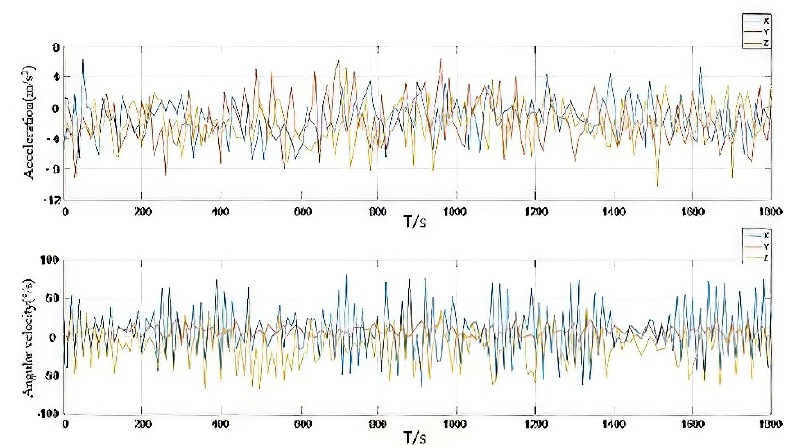
Figure 7. Accelerometer data and gyroscope data.